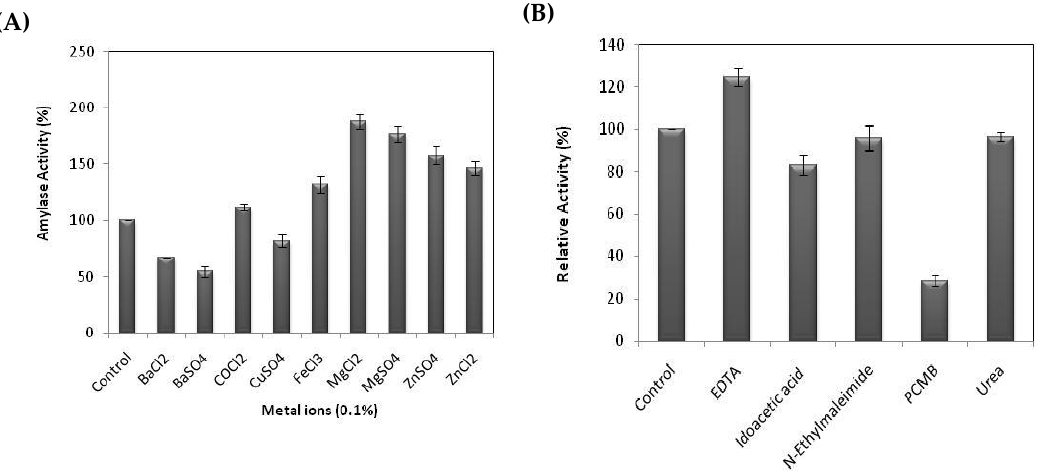
Figure 8. Influence of metal ions (0.1%) ( A ) and chemical reagents ( B ) (5 mM) on Bacillus pacificus α-amylase activity.